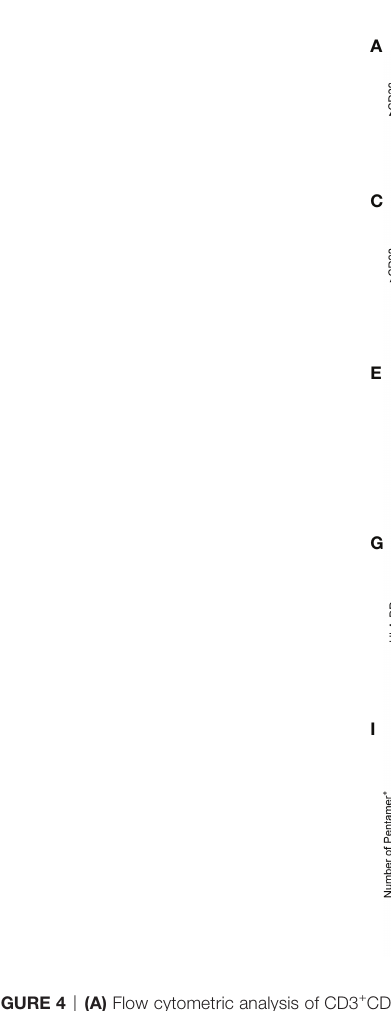
FIGURE 4 | (A) Flow cytometric analysis of CD3 + CD8 + PD-1 + or CD28 + T cells among PMBCs from males or females after vaccination. Dot plots of CD28 and PD-1 expression in PI - CD3 + CD8 + PMBCs are shown. (B) Frequency of CD28 + or PD-1 + CD8 + T cells among PMBCs from males or females after vaccination. (C) Flow cytometric analysis of CD3 + CD8 + COVID-19-pentamer + PD-1 + or CD28 + T cells among PMBCs from males or females after vaccination. Dot plots of CD28 and PD-1 expression in PI - CD3 + CD8 + COVID-19-pentamer + PMBCs are shown. (D) Frequency of CD28 + or PD-1 + COVID-19-pentamer + CD8 + T cells among PMBCs from males or females after vaccination. (E) Flow cytometric analysis of CD3 + CD8 + CD38 - HLA-DR - , CD38 + HLA-DR - , CD38 + HLA-DR + and CD38 - HLA-DR + T cells among PMBCs from males or females after vaccination. Dot plots of CD38 and HLA-DR expression in PI - CD3 + CD8 + PMBCs are shown. (F) Frequency of CD38 - HLA-DR - , CD38 + HLA-DR - , CD38 + HLA-DR + and CD38 - HLA-DR + CD8 + T cells among PMBCs from males or females after vaccination. (G) Flow cytometric analysis of CD3 + CD8 + COVID-19-pentamer + CD38 - HLA-DR - , CD38 + HLA-DR - , CD38 + HLA-DR + and CD38 - HLA-DR + COVID-19-pentamer + CD8 + T cells among PMBCs from males or females after vaccination. Dot plots of CD38 and HLA-DR expression in PI - CD3 + CD8 + COVID-19-pentamer + PMBCs are shown. (H) Frequency of CD38 - HLA-DR - , CD38 + HLA-DR - , CD38 + HLA-DR + and CD38 - HLA-DR + COVID-19-pentamer + CD8 + cells among PMBCs from males or females after vaccination. (I) Scatter plots of the number of pentamer + CD38 - HLA-DR + CD8 + T cells and percent of COVID-19-pentamer + CD8 + T cells after vaccination. *p < 0.05; n.s., not signi fi